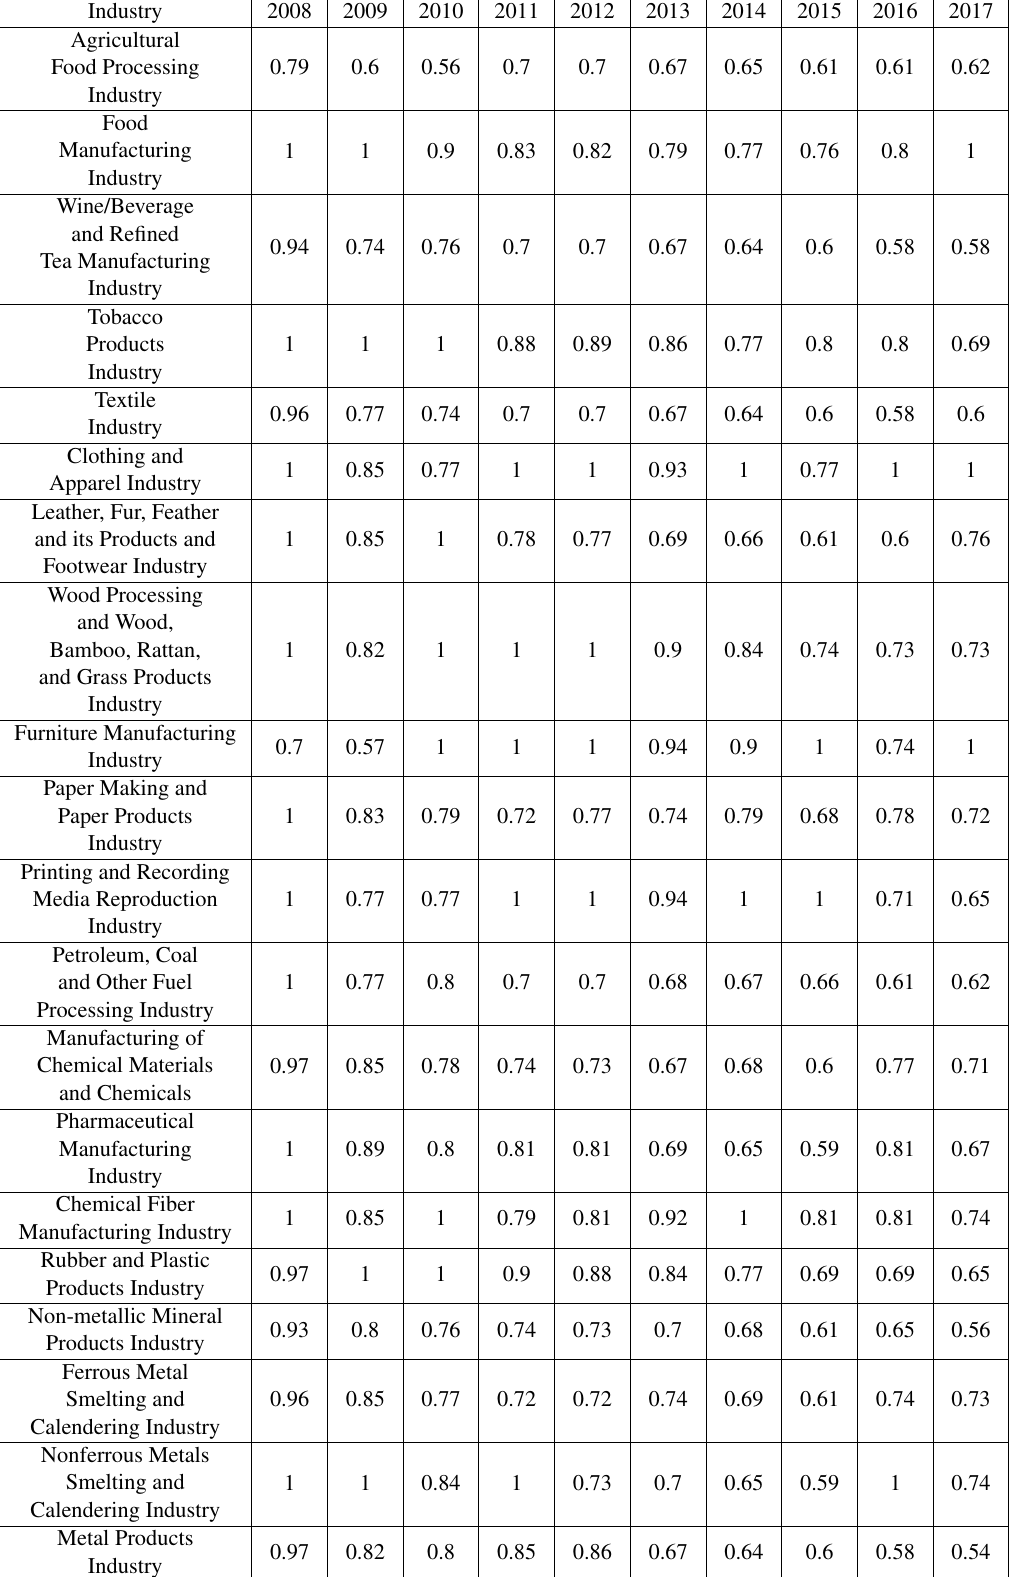
Table 4 Comprehensive efficiency value of manufacturing industry in Chongqing from 2008 to